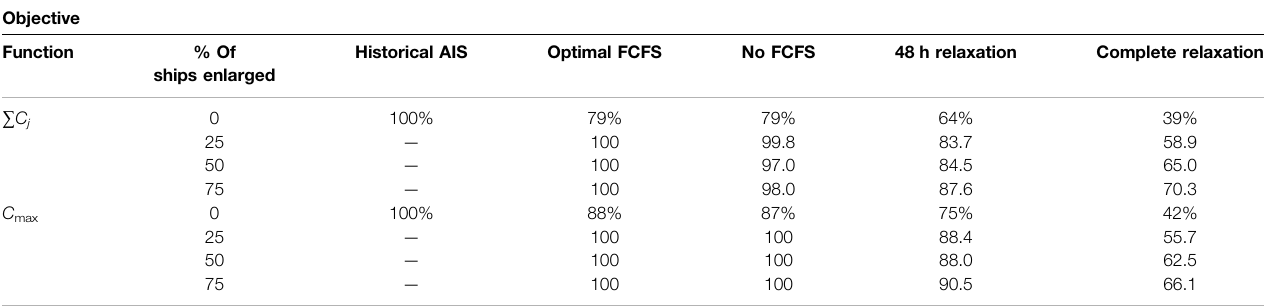
TABLE 2 | Percentual Performance of Model Types (lower is